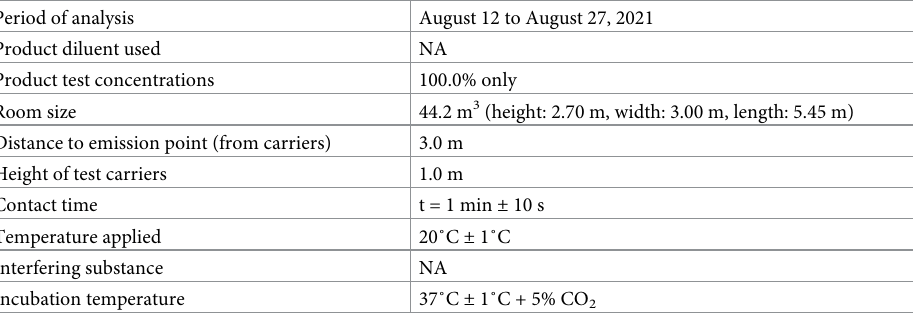
Table 2. Experimental conditions.